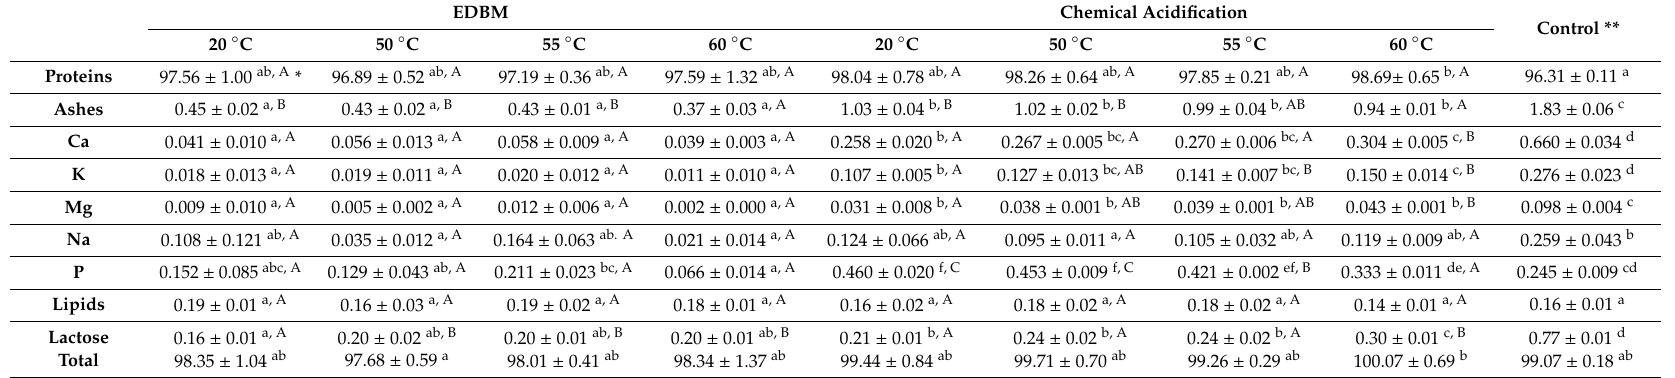
Table 2. Composition of final precipitates on dry basis in comparison with the control (g / 100 g dry